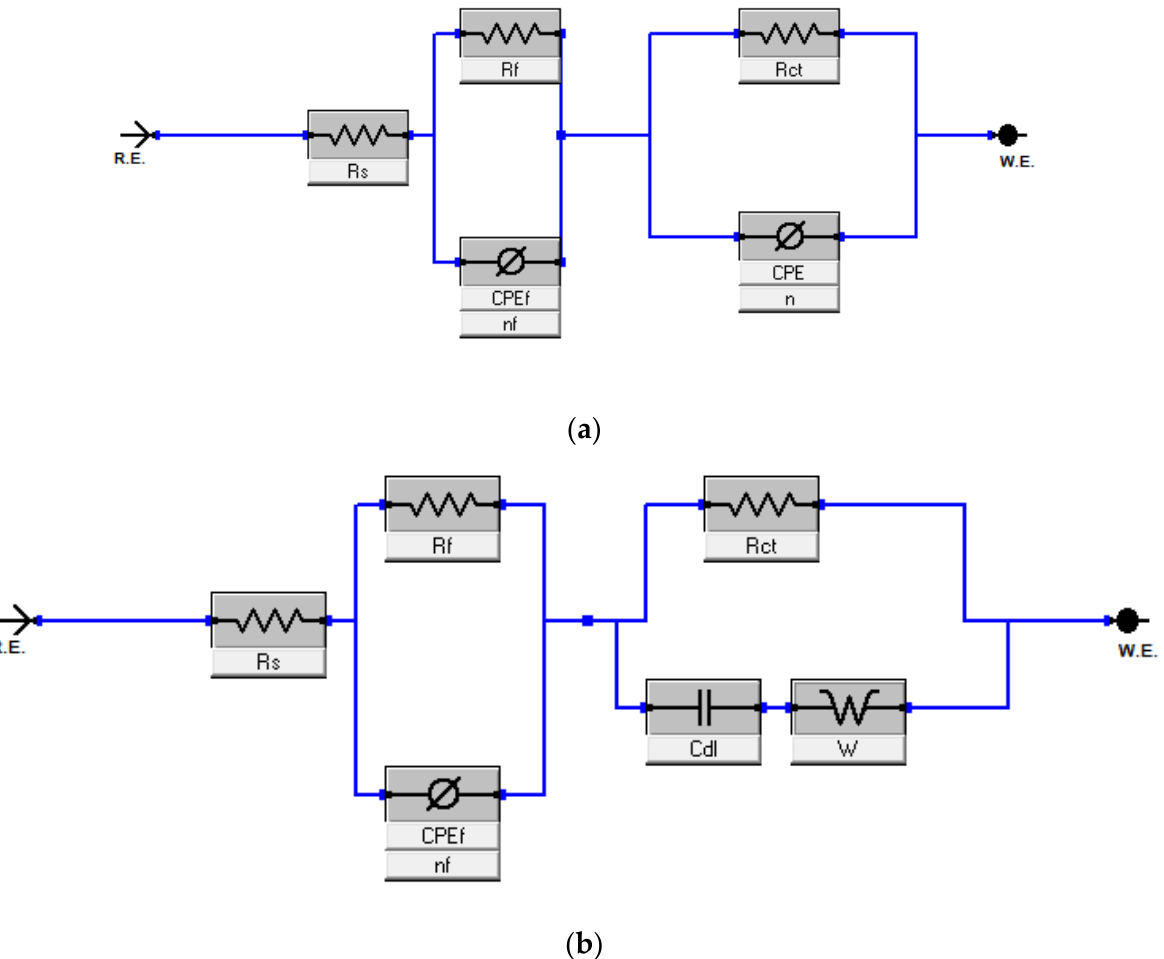
Figure 2. Equivalent circuits ( a ) Model 1 and ( b ) Model 2 used to fit the impedance data of the Harmal extracts.